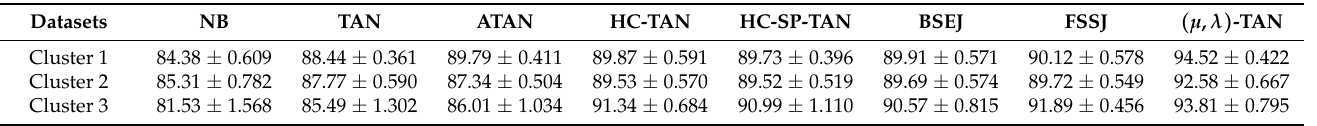
Table 3. Performance comparison of NB, TAN, ATAN, HC-TAN, HC-SP-TAN, BSEJ, FSSJ, and ( µ , λ ) -TAN in terms of precision in the test set.